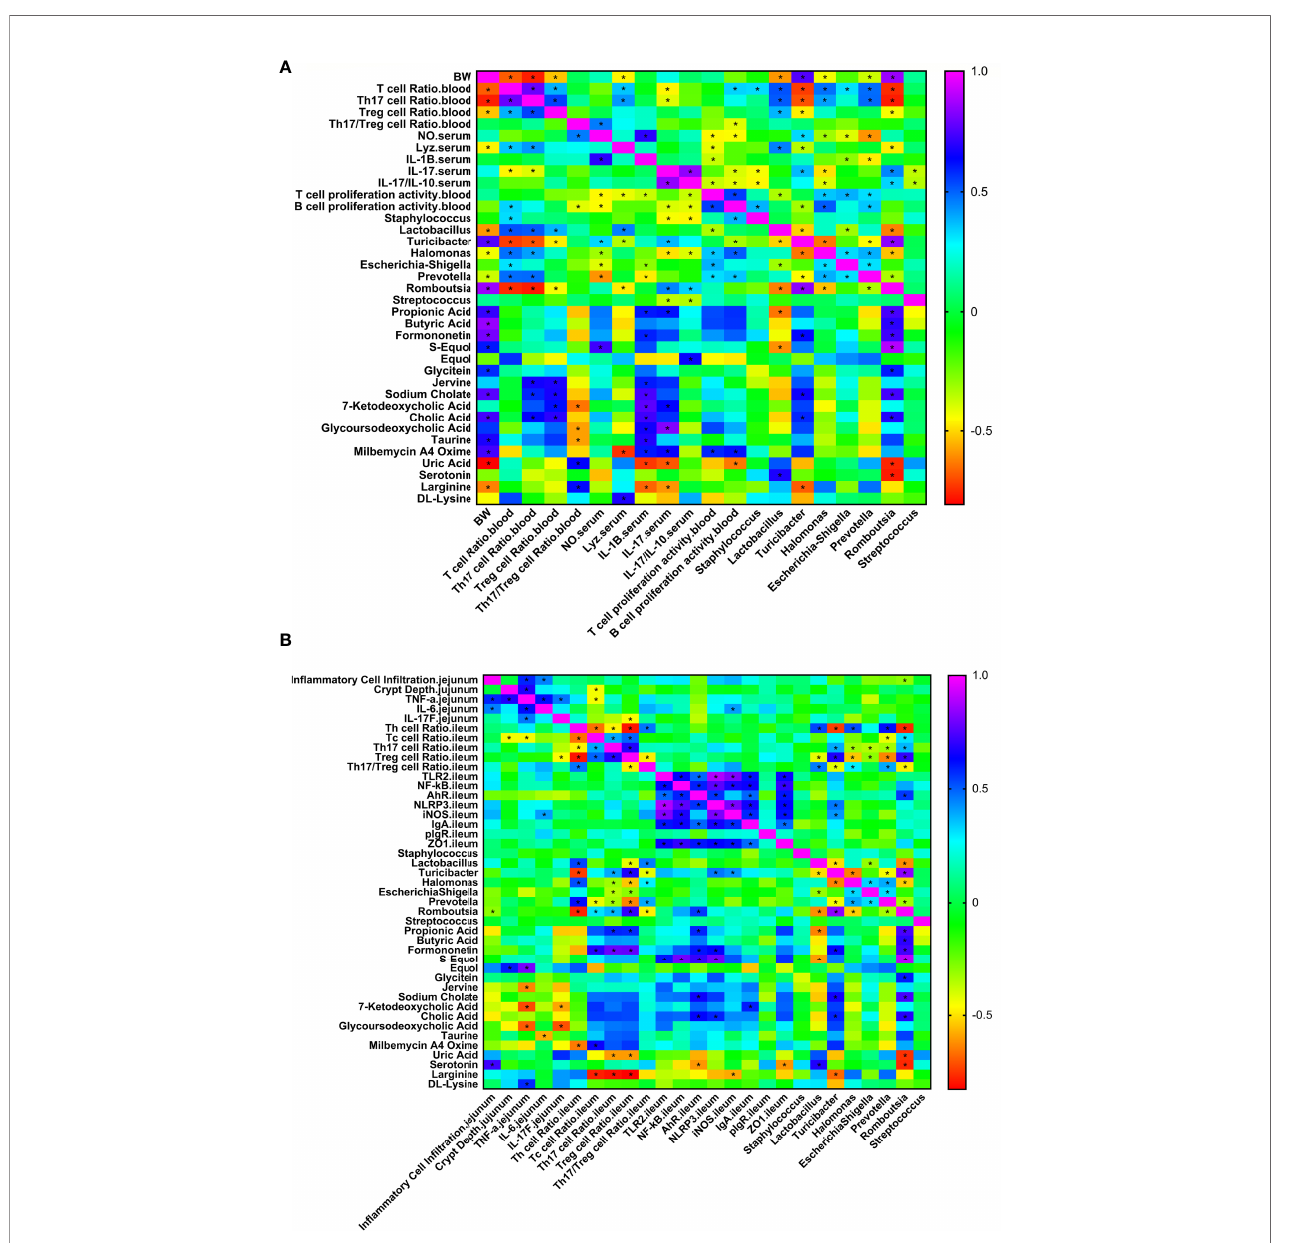
FIGURE 9 | Correlation heat map of ileum differential bacteria and differential immune function of broiler chickens. Spearman ’ s correlations were calculated for all signi fi cantly different peripheral (A) and intestinal (B) immune indexes and different ileal microbes on genus level. Colors of squares represent r values of spearman ’ s correlation coef fi cient. * P <